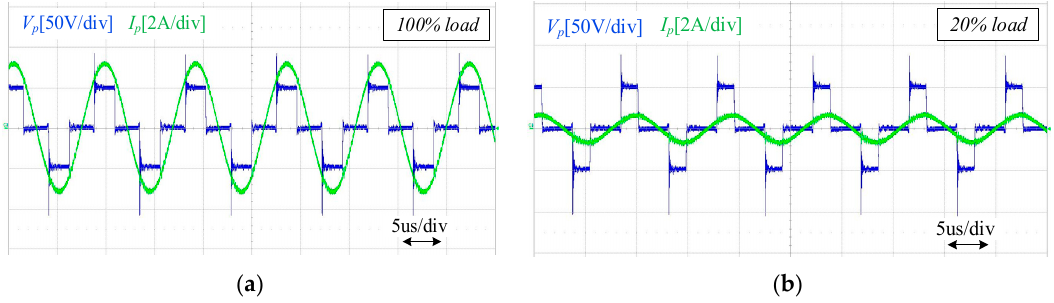
Figure 9. Waveforms of the primary side voltage ( V p ) and current ( I p ) at ( a ) 100% load ( R L = 12 Ω ) and ( b ) 20% load ( R L = 60 Ω ).